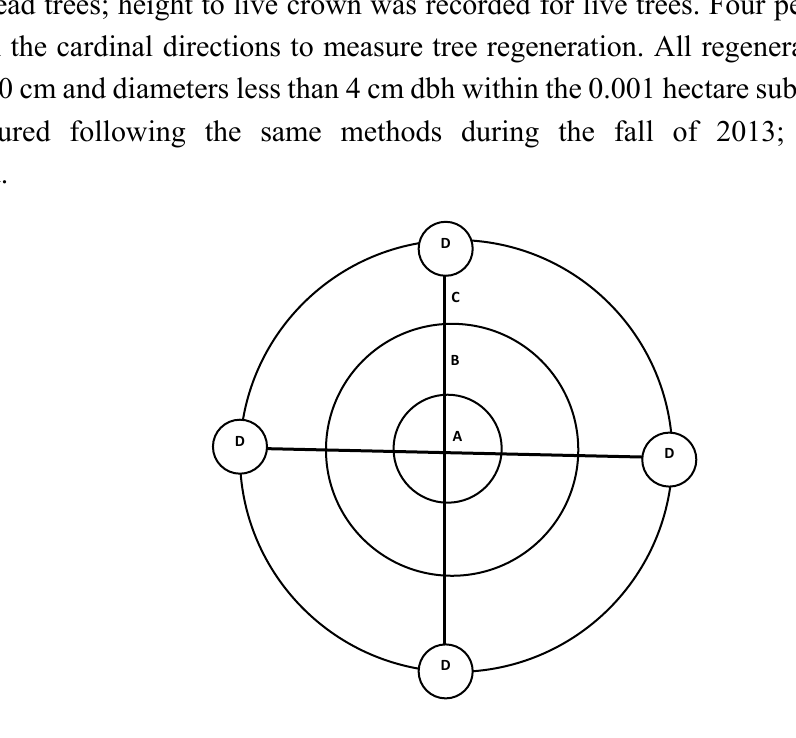
Figure 2. Permanent plot design established in 2008 and remeasured in 2013. The radius of the nested subplots increased in size from the center point; (A) 0.01 hectare plot measuring trees between 4.1 and 10 cm dbh; (B) 0.05 hectare plot measuring trees between 10.1 and 25 cm dbh; (C) 0.10 hectare plot measuring trees greater than 25 cm dbh. Regeneration plots were established at the four cardinal directions; (D) 0.001 hectare measuring tree regeneration with heights greater than 20 cm and diameters less than 4 cm